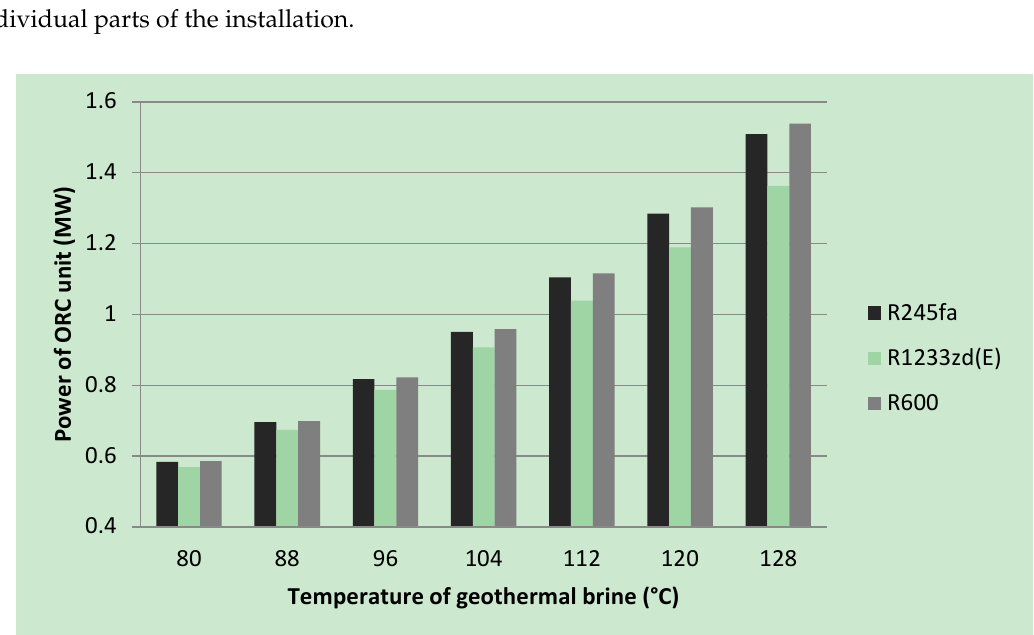
Figure 4. The power of the modified ORC system (assisted by gas turbine) as a function of the geothermal brine temperature. The change of the fossil fuel utilization factor (FFUF) for the designed installation as a function of the geothermal brine temperature is presented in Figure 5. As mentioned before, this ratio is defined as the ratio of combined system power to heat supplied from the combustion of fossil fuel in